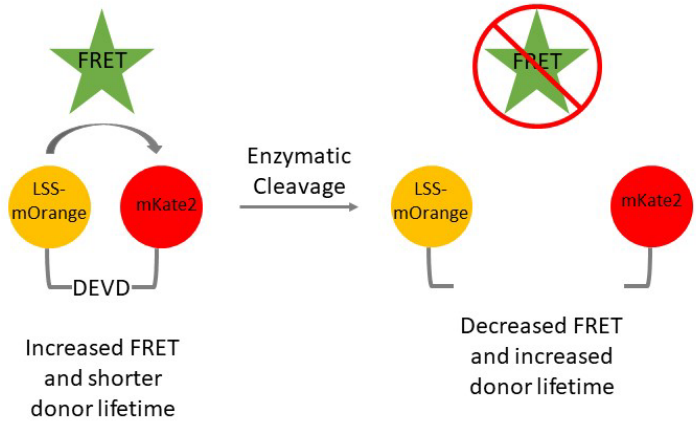
Figure 1. Schematic representation of the LSS-mOrange-DEVD-mKate2 reporter. The intact DEVD linker between LSS-mOrange and mKate2 causes the two fluorescent proteins to be spatially close and experience increased FRET. This increase in FRET causes a decrease in the donor (LSS-mOrange) lifetime. Once the DEVD linker is enzymatically cleaved by active caspase-3, LSS-mOrange and mKate2 can spatially separate. This causes FRET to decrease and the donor (LSS-mOrange) lifetime to increase.